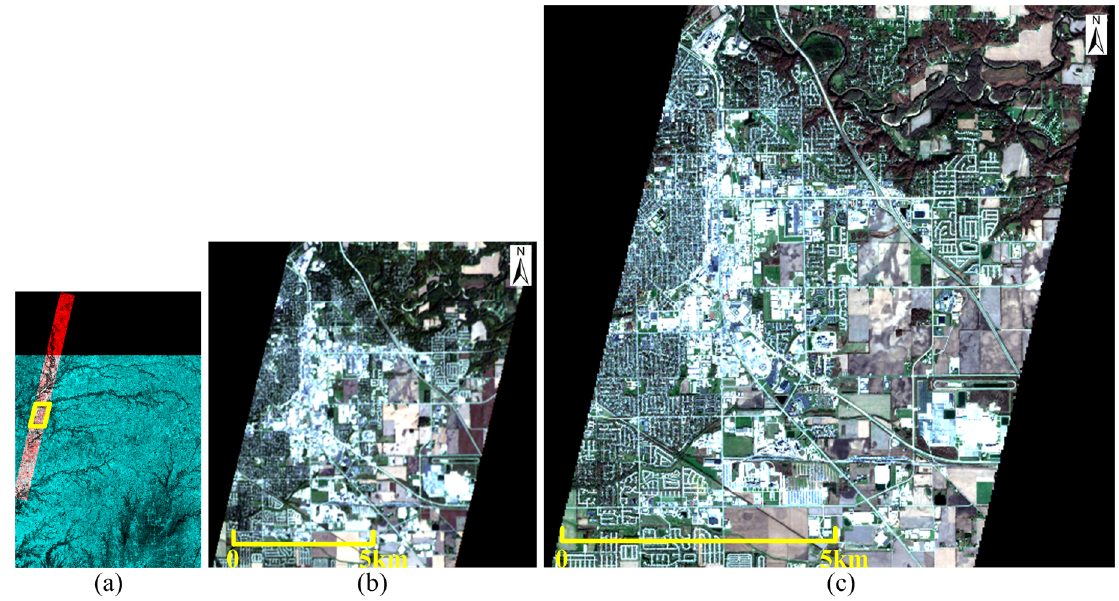
Figure 9. The experiment data taken over Lafayette, ( a ) illustration of Hyperion and Sentinel-2A data, the red part is Hyperion data, the green part is Sentinel-2A data, the white part is the overlapped region, the yellow line indicates the study area; ( b ) color composite (bands 31, 21, 14) of Hyperion data in the study area with size 341 × 365; ( c ) color composite (bands 4, 3, 2) of Sentinel-2A data in the study area with size 1023 × 1095.